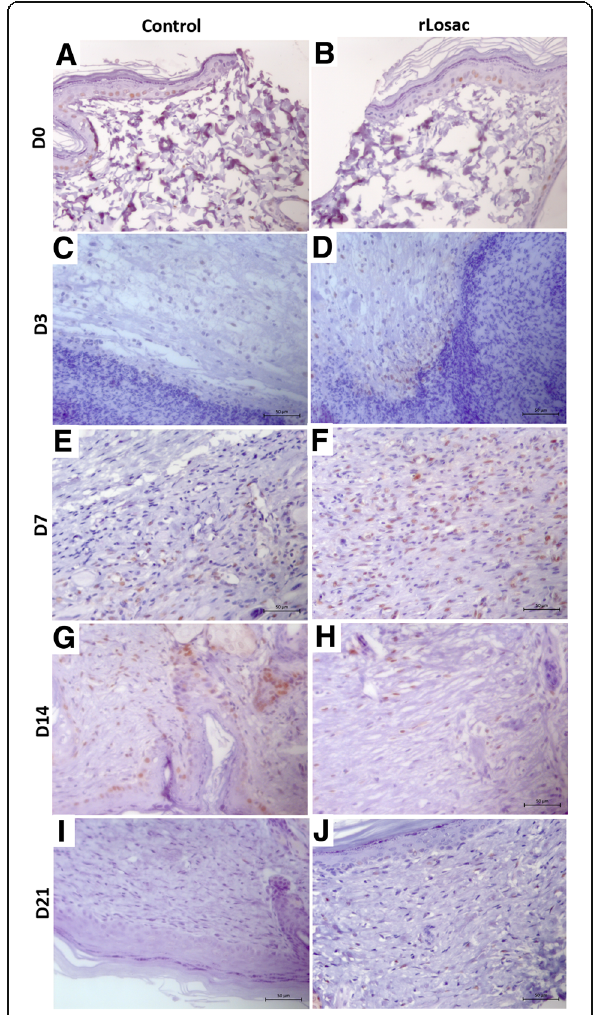
Fig. 3 Representative micrographies of PCNA immunohistochemistry. Assessment of scar tissue during the experiment period. Micrographies of scar tissue evaluated at day zero: a control group, b treated group; day 3: c control group, d treated group; day 7: e control group, f treated group; day 14: g control group, h treated group; day 21: i control group, j treated group. All areas shown with increases of